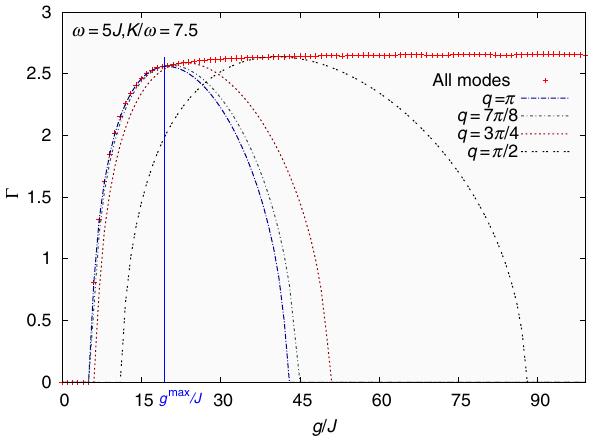
FIG. 8. Total instability rate Γ (red crosses) and instability rates s of a few individual modes (dashed lines), numerically q computed as a function of interaction strength g for ω ¼ 5 J and K= ω ¼ 7 . 5 . The instability rate associated with an individual q Þ ¼ ω and decreases around it. The mode q is maximal for E av ð total instability rate is given by the envelope of all those